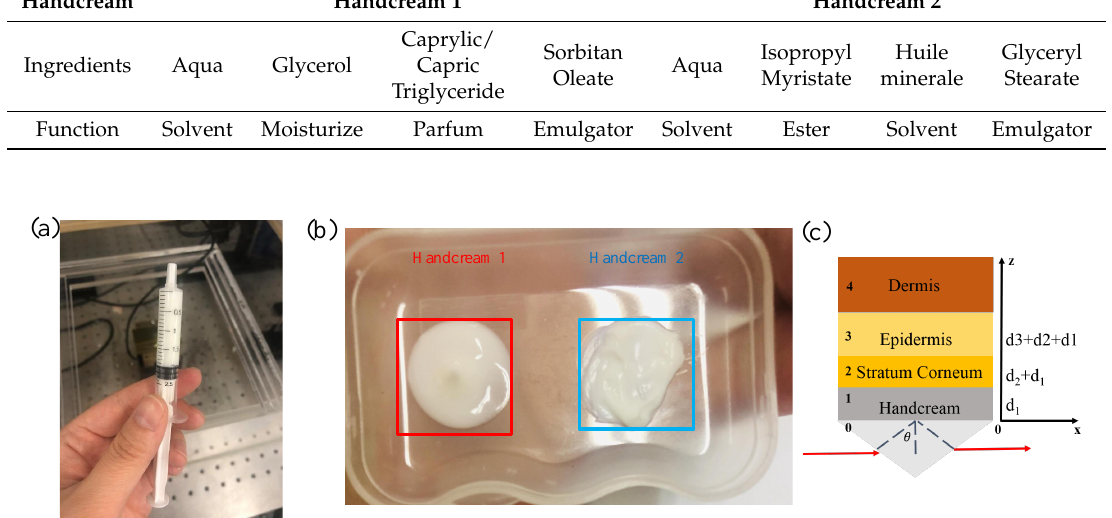
Figure 9. ( a ) 2 mL handcream; ( b ) textures of two types of handcream; ( c ) schematic illustration of the stratified media